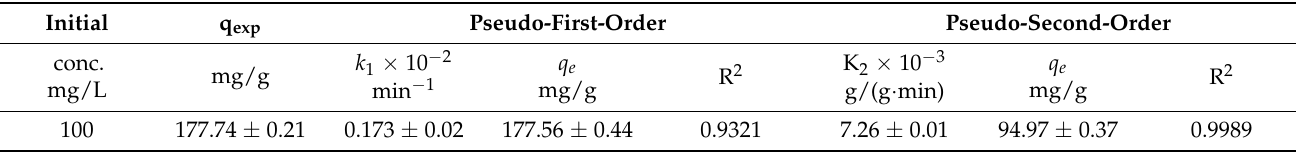
Table 1. Parameters of the kinetics model for the adsorption of Zn 2+ with MnO 2 @PSS/PDDA/PSS, with an initial concentration of 100 mg/L, under a pH of 13.0 at 25 ◦ C.